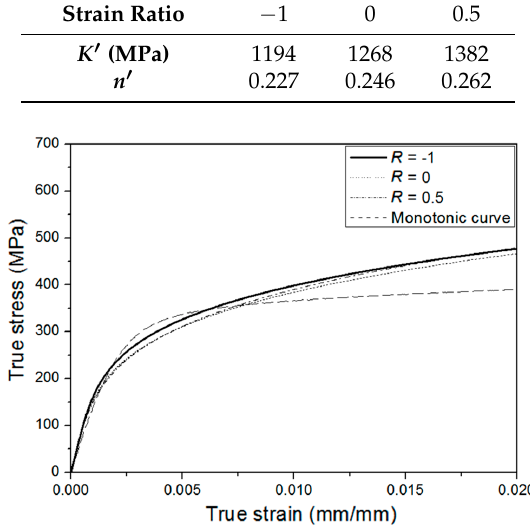
Table 5. K (cid:48) and n (cid:48) for three different strain ratios. Table 5. K ′ and n ′ for three different strain ratios. Table 5. K ′ and n ′ for three different strain ratios.